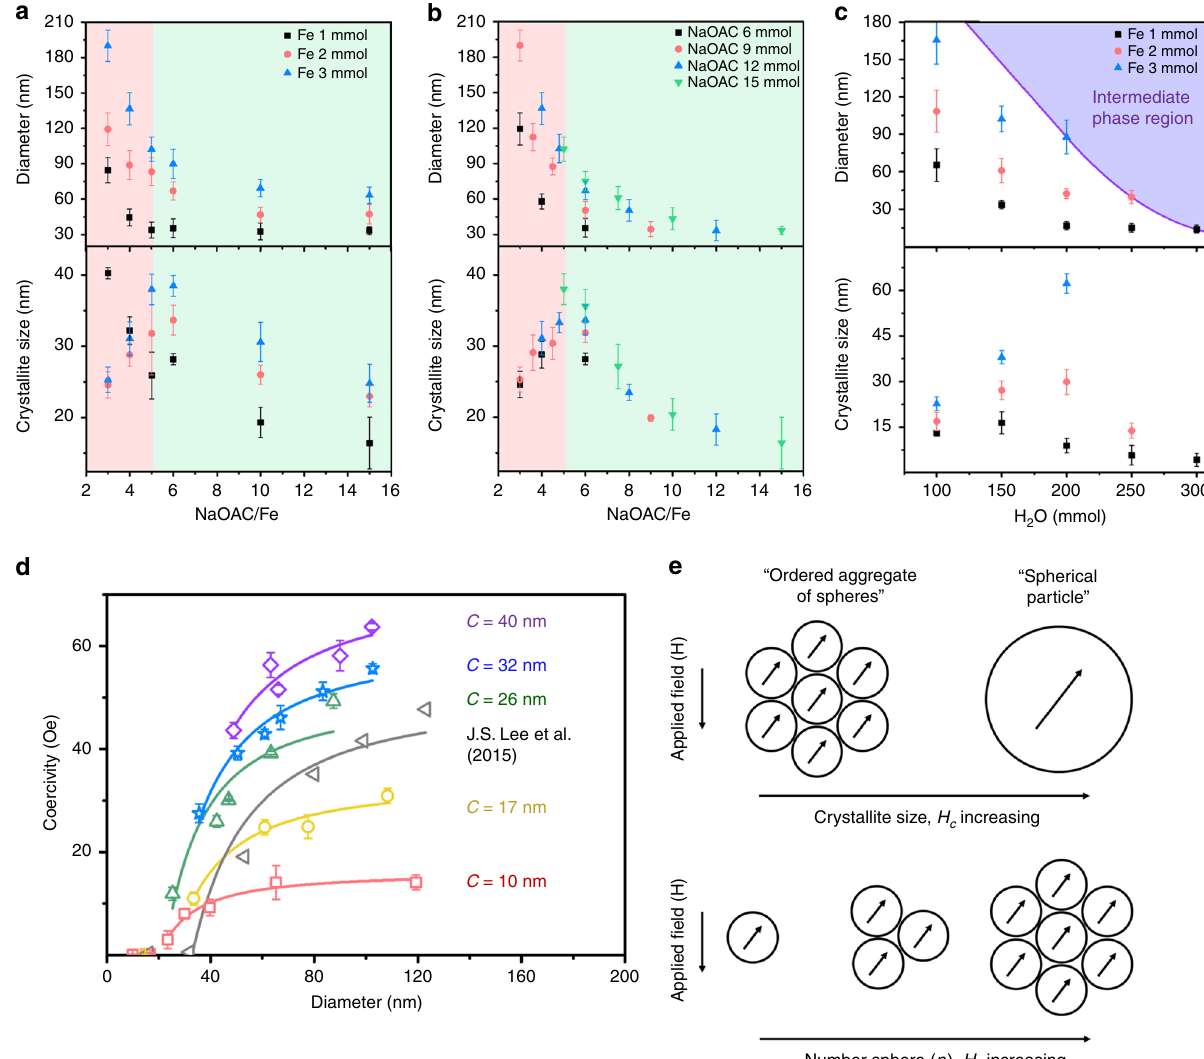
Fig. 5 Crystallite size effect on H c fi tting as a function of the diameter of the mesocrystal. a Effect of NaOAC, b Fe precursor, and c H 2 O contents on the diameter and crystallite size of Fe 3 O 4 mesocrystals. Red and green regions denote the regions where the crystallization pathways 1 and 2, respectively, govern the entire reaction. The solid purple line serves as a guide to the eye. Error bars indicate standard deviations. d H c fi tting depending on the diameter and crystallite size of the Fe 3 O 4 mesocrystals. We expressed H c as a function of the mesocrystal diameter for fi ve groups with different average crystallite sizes. Error bars indicate standard deviations. The smallest mesocrystal for each group is almost a single crystal with a diameter comparable to the crystallite size. The fi tted curves are represented by solid lines. e Schematic illustration of Fe 3 O 4 mesocrystal as an ordered aggregate of